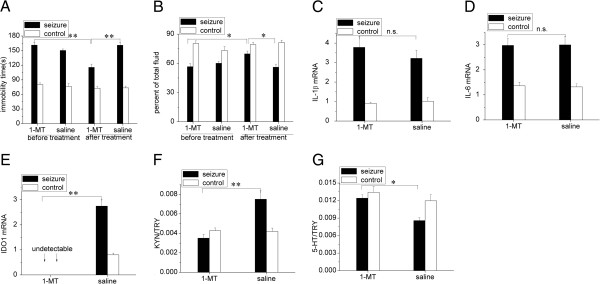
1-Methyltryptophan blocks chronic temporal lobe epilepsy-induced depressive behaviors, inhibits indoleamine 2,3-dioxygenase expression, and normalizes tryptophan metabolites without reducing IL-1β and IL-6 expression in the hippocampus. (A) Compared with saline treatment, the immobility time was diminished in the forced swim test (**P < 0.01 versus before treatment by paired t-test; **P < 0.01 versus saline treatment by one-way analysis of variance (ANOVA)). (B) Saccharin consumption was improved in TPT after 1-methyltryptophan (1-MT) treatment in chronic epileptic rats (*P < 0.05 versus before treatment by paired t-test; * P < 0.05 versus saline treatment by one-way ANOVA). (C) IL-1β and (D) IL-6 expression were unaffected by 1-MT treatment but (E) indoleamine 2,3-dioxygenase 1 (IDO1) expression was inhibited. (F) Kynurenine (KYN)/tryptophan (TRY) and (G) serotonin (5-HT)/TRY ratios were normalized in the hippocampus of chronic epileptic rats. Statistical significance was determined using paired t-test and one-way ANOVA. The data are presented as means ± SEM, n = 5 to 6; *P < 0.05; **P < 0.01; n.s., not statistically significant (P > 0.05).